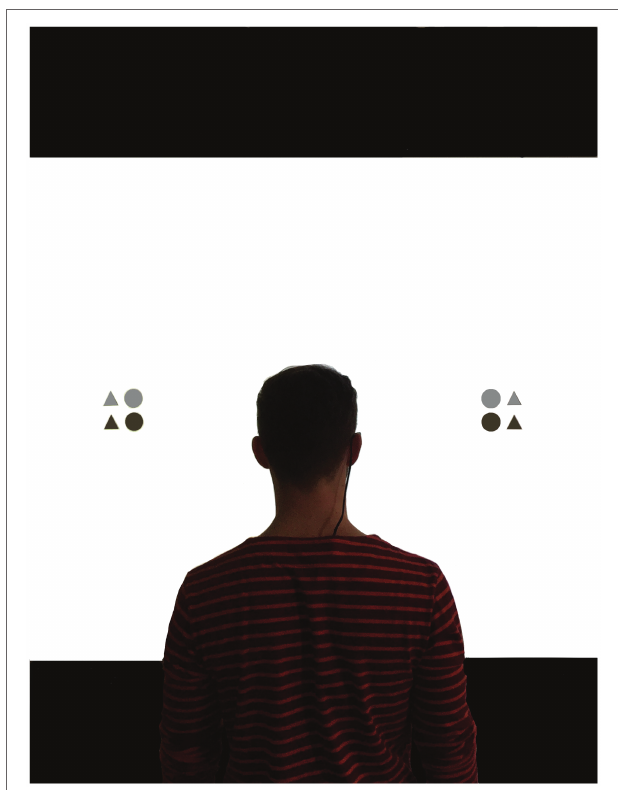
FIGURE 2 | The experimental setup with a participant wearing the mobile eye-tracking system and standing in front of the screen while completing the attention window task with stimuli presented along the horizontal